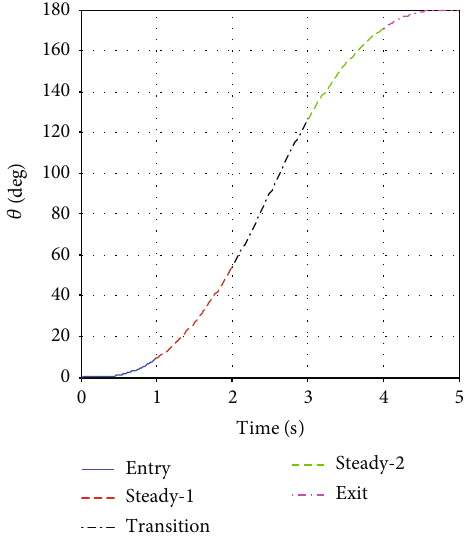
Figure 4: Trajectory of acceleration of